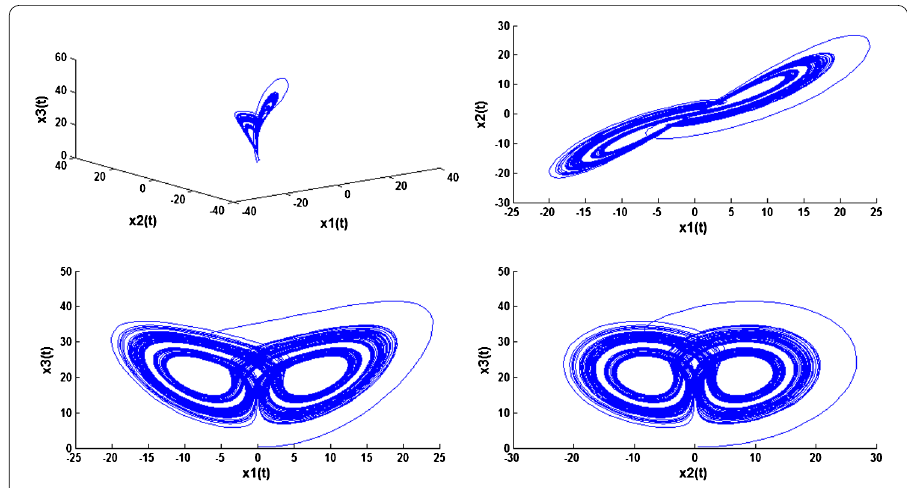
Figure 4 Different plots of the chaotic attractor of the incommensurate fractional Lü system (35).